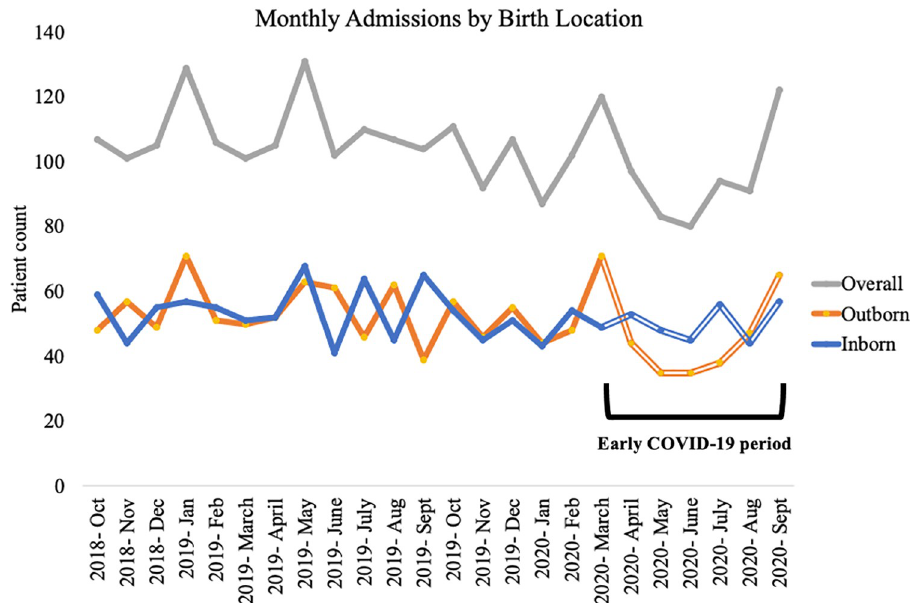
Fig 1. Admissions by birth location. Proportion of admissions of outborn patients decreased to 46.1% during the early COVID period (April–September 2020) from 51.6% pre-COVID (October 2019 to March 2020). All transport was banned or tightly limited during April and May and public transport was costly and restricted during June and July. “Outborn” refers to patients born outside KH. “Inborn” includes those born at KH.